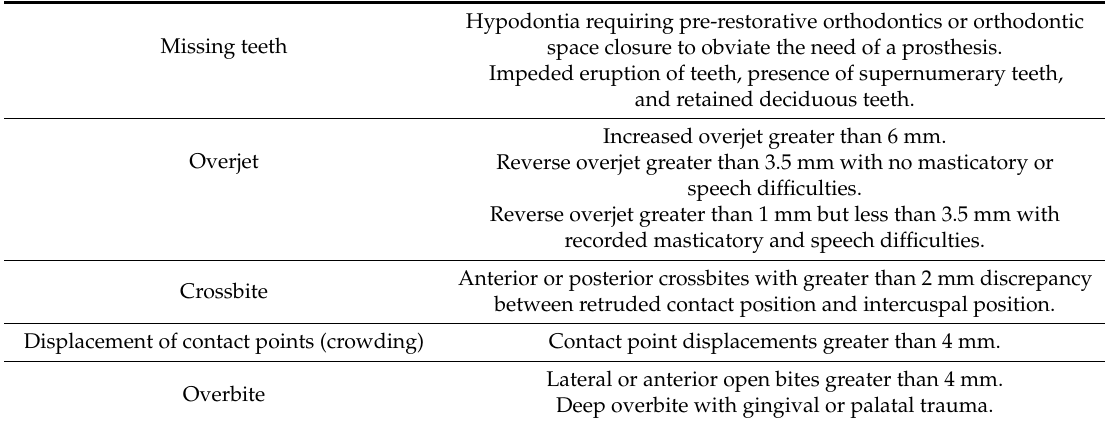
Table 1. Modified version of the Index of Orthodontic Treatment Need